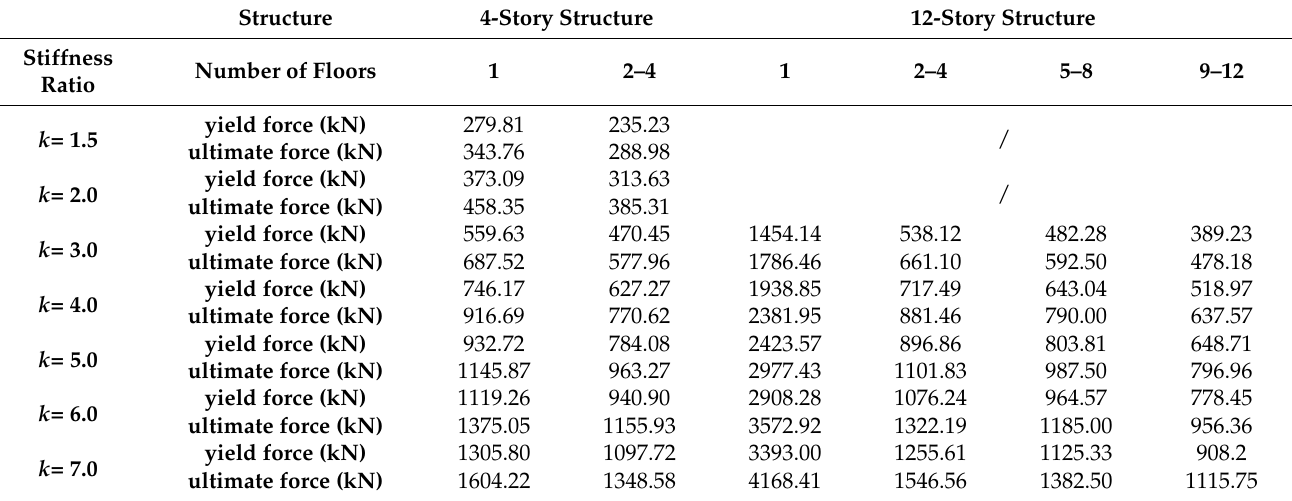
Table 10. Input yield force and the ultimate force of